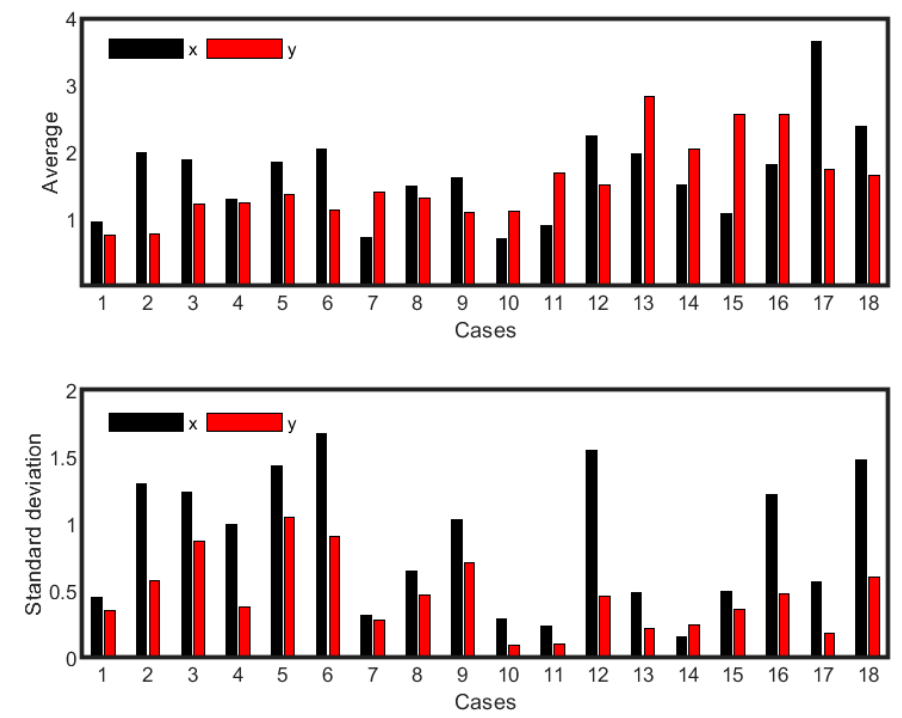
Figure 5. ( a ) Average (m) of x and y locations for the 18 cases; ( b ) standard deviation (m) for x and y locations for the 18 cases at the end of simulation.